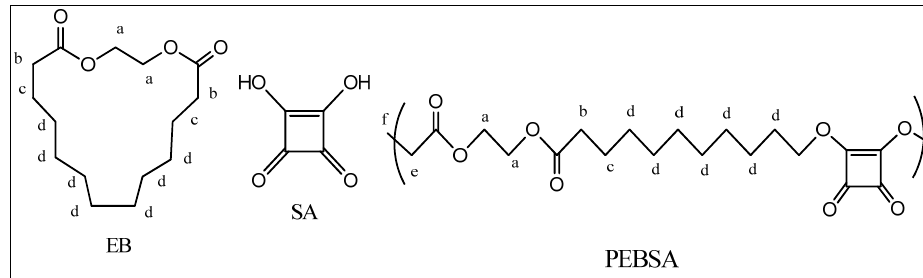
Figure 2. Chemical structure of monomers, copolymacrolactone, and notation of protons.